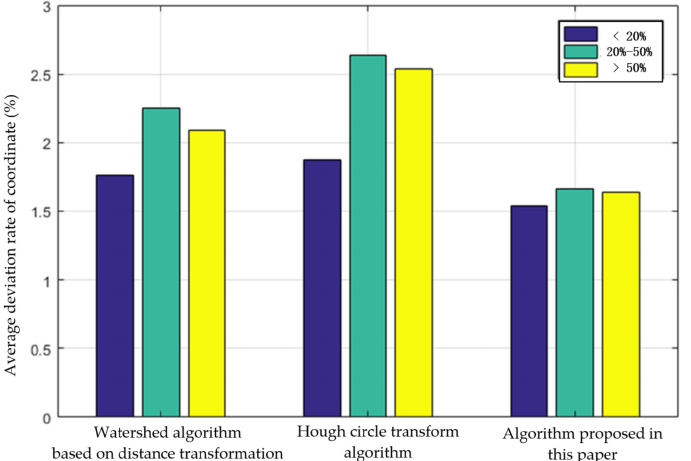
Figure 19. Comparison of average deviation rate of Agaricus bisporus coordinates under different overlap rates.